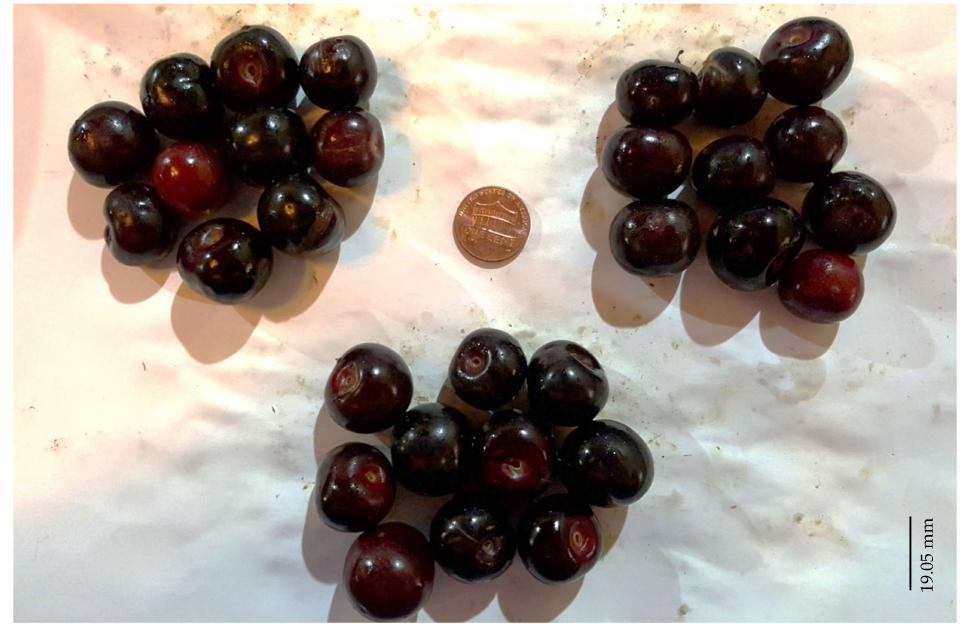
Figure 2. Fruits of Prunus serotina subsp. capuli , genotype PserTU48, collected in the Andes region of Ecuador in 2016. A US one cent coin was used as a size reference (diameter 19.05